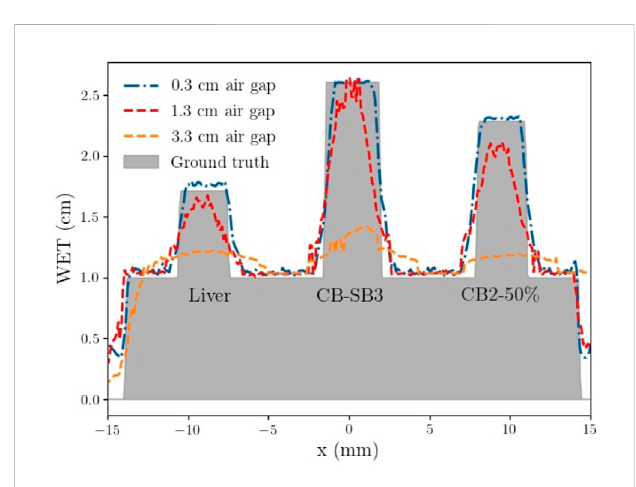
FIGURE 9 Line pro fi les through three different inserts and ground truth (line indicated in Figure 8) for the radiographic acquisition at